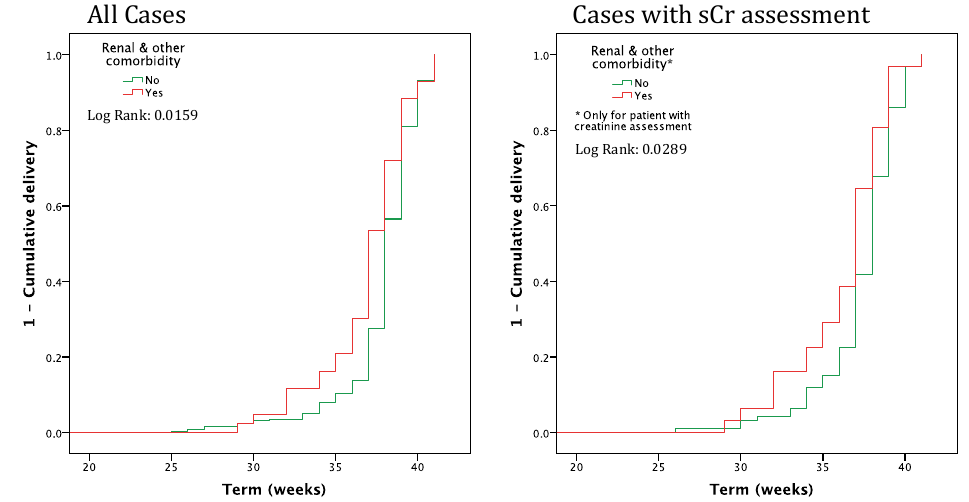
Figure 2. Timing of delivery in pregnancies from egg donation, with and without “renal or other” comorbidity (all cases and cases with serum creatinine assessment). sCr: Serum creatinine. The presence of a higher serum creatinine or a lower eGFR is likewise significantly correlated with timing of delivery (Figure 3).